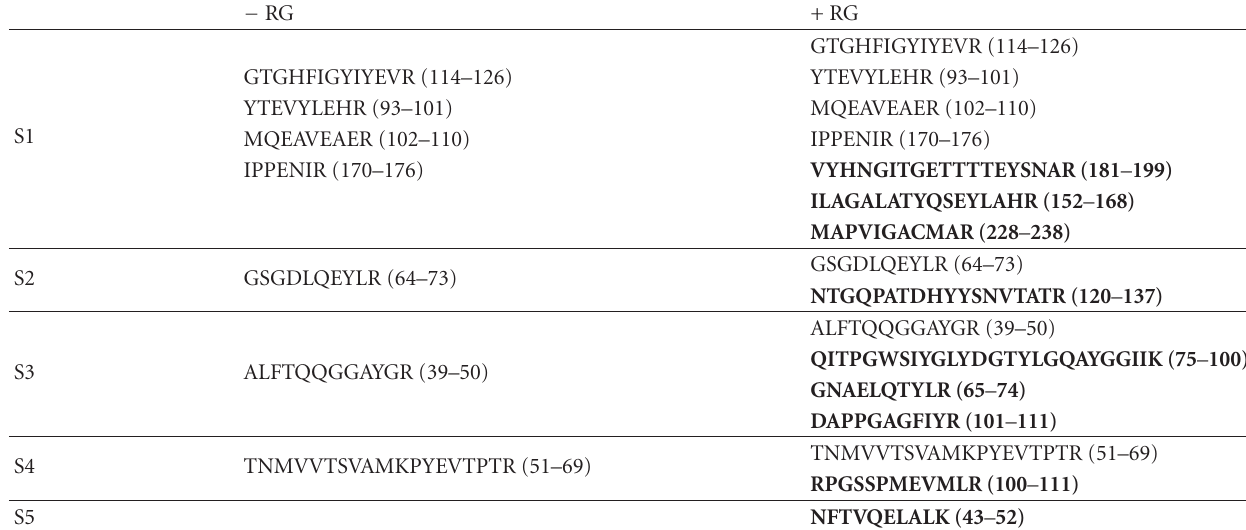
Table 4: Peptide detection among pertussis toxin and toxoid subunits ( − /+ rapigest treatment). − RG